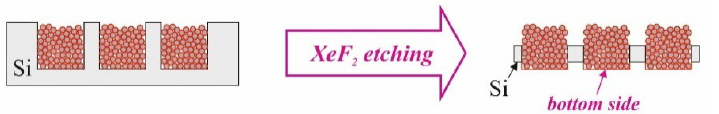
Figure 15. Schematic illustration of the etching in XeF 2 gas phase applied to remove the silicon substrate surrounding the NdFeB-based micromagnets and to expose their bottom side.